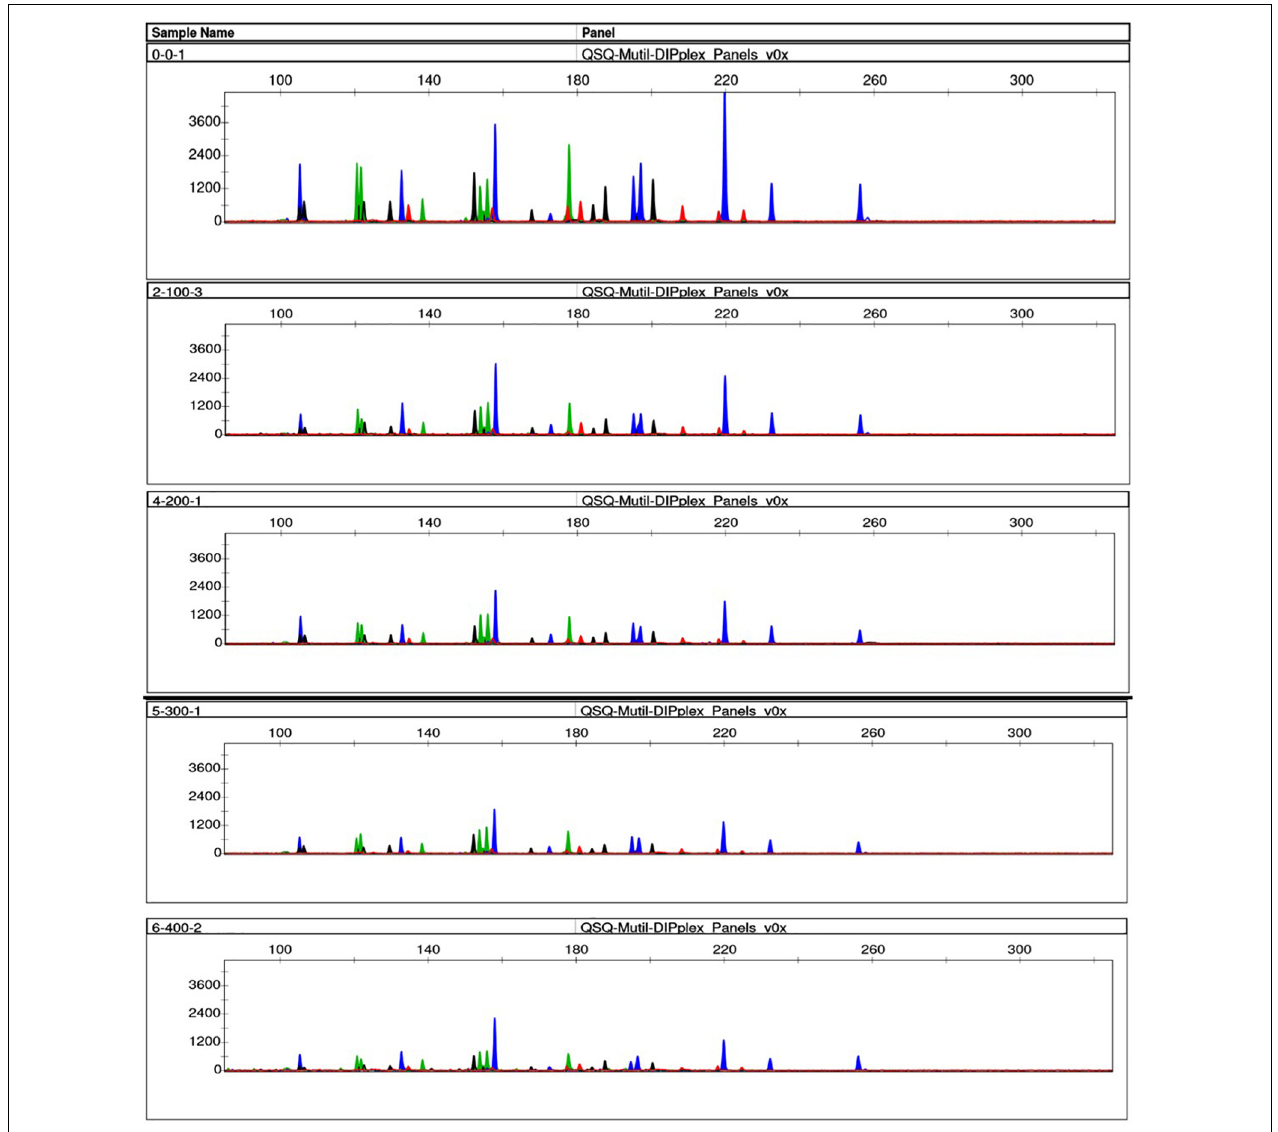
FIGURE 4 | Effects of ultrasound on degraded control DNA M308. We degraded control DNA using 0 (top) , 100, 200, 300, and 400 (bottom) ultrasonic cycles of 200 W for 10 s per cycle, with 4 s between